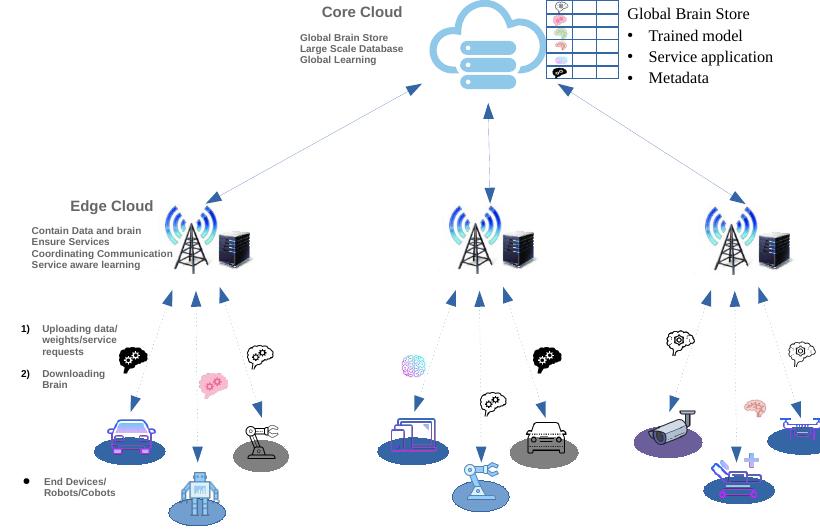
Figure 1. Proposed Brainware